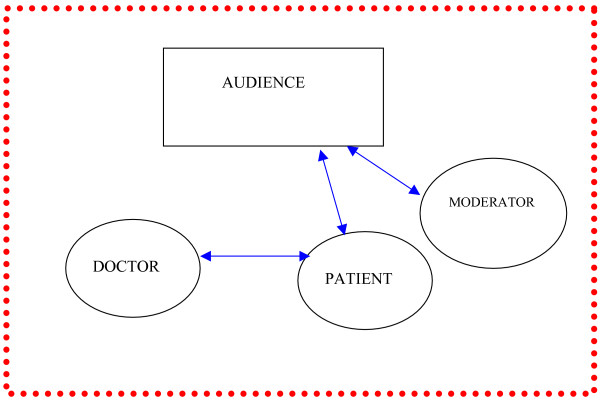
Location 3. The remove of the fourth wall opens up for a possible communication between everybody in the room.